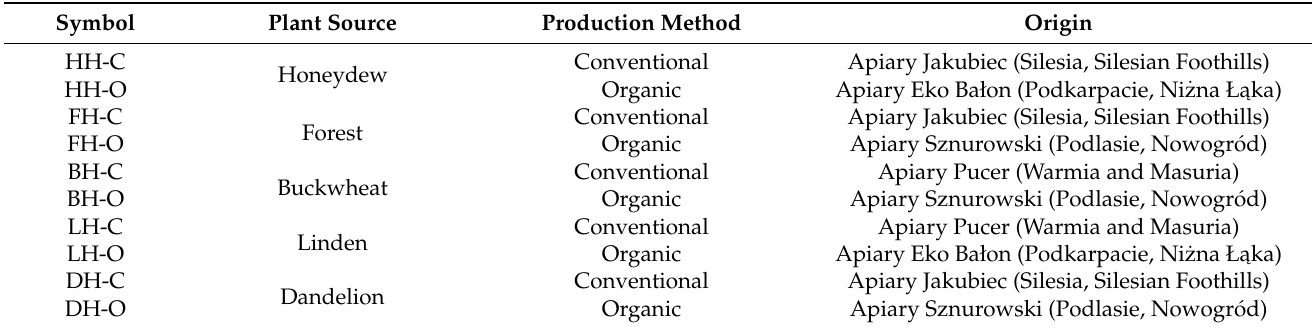
Table 7. Origin of honey